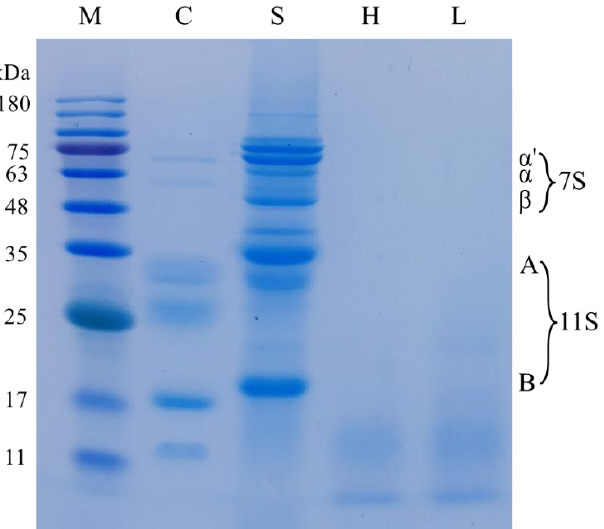
Figure 1. Sodium dodecyl sulfate polyacrylamide gel electropheresis for the control, soymilk and enzyme modified soymilk. M, marker; C, skim milk; S, soymilk; H, high degree of hydrolysis of soymilk; L, low degree of hydrolysis of soymilk. 7S and 11S indicate the relative proteins in